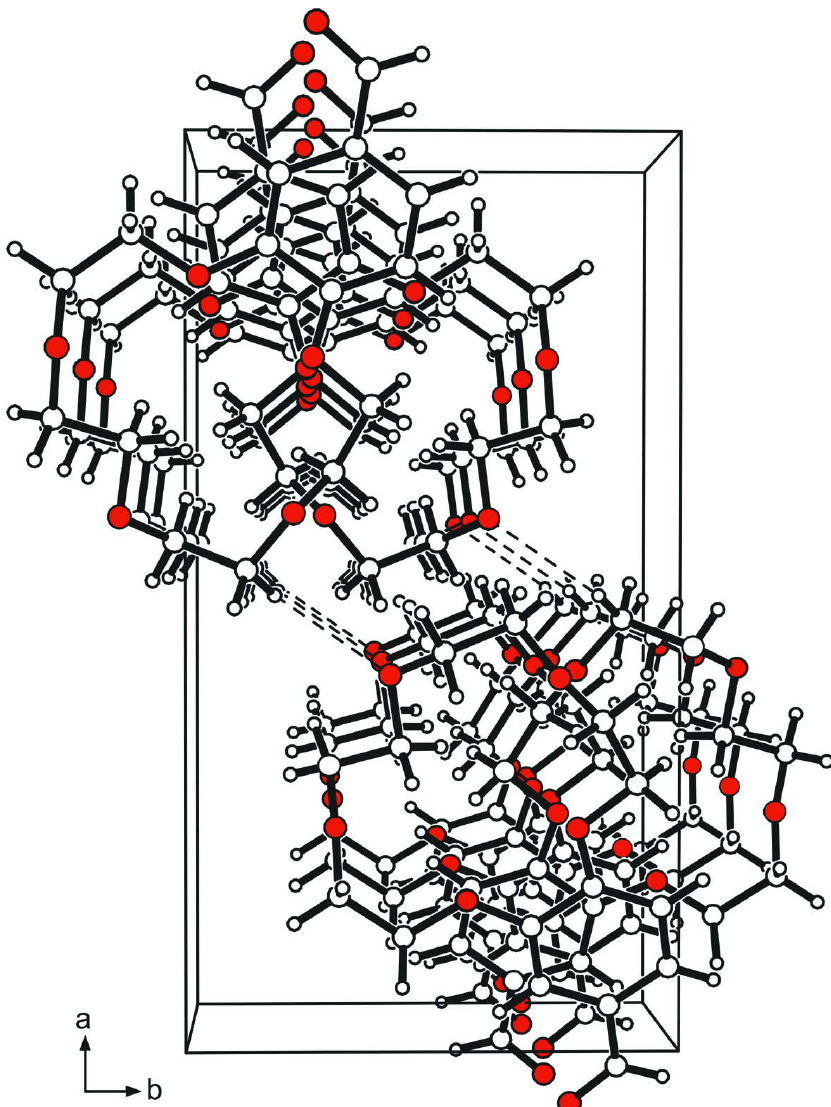
Packing diagram, viewed down the c